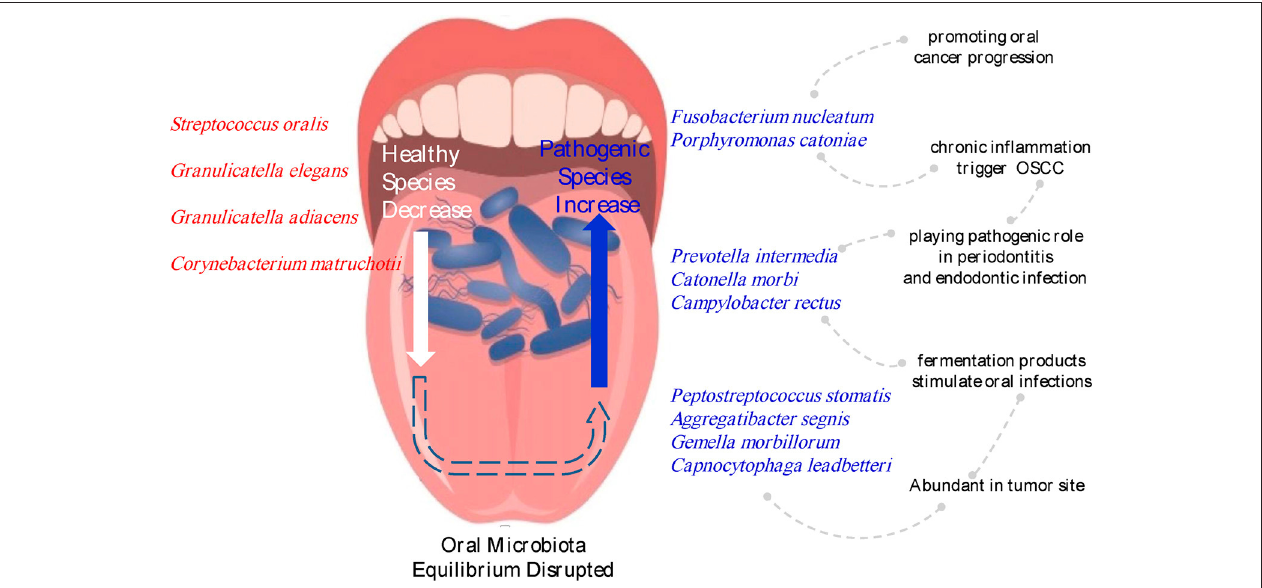
FIGURE 6 | Changes in the microbiota composition associated with OSCC. Species names labeled with red indicate bacteria enriched in normal sites, and species names labeled with blue indicate bacteria increased in tumor